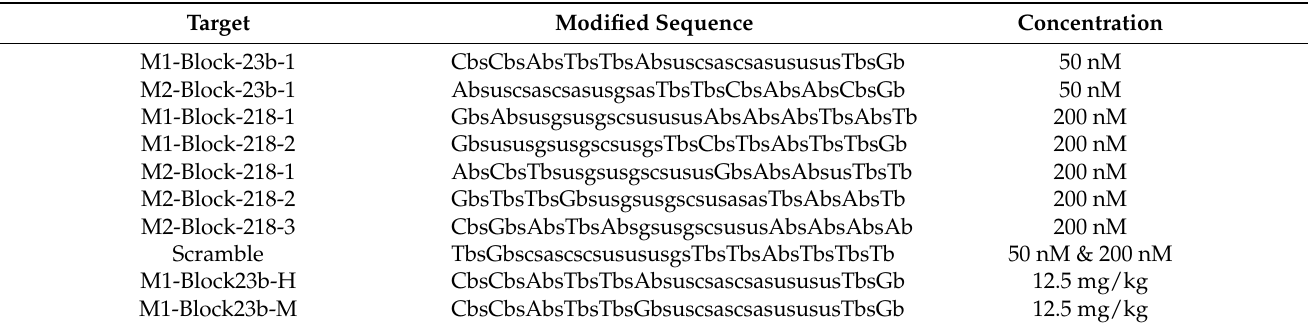
Table 1. BlockmiR